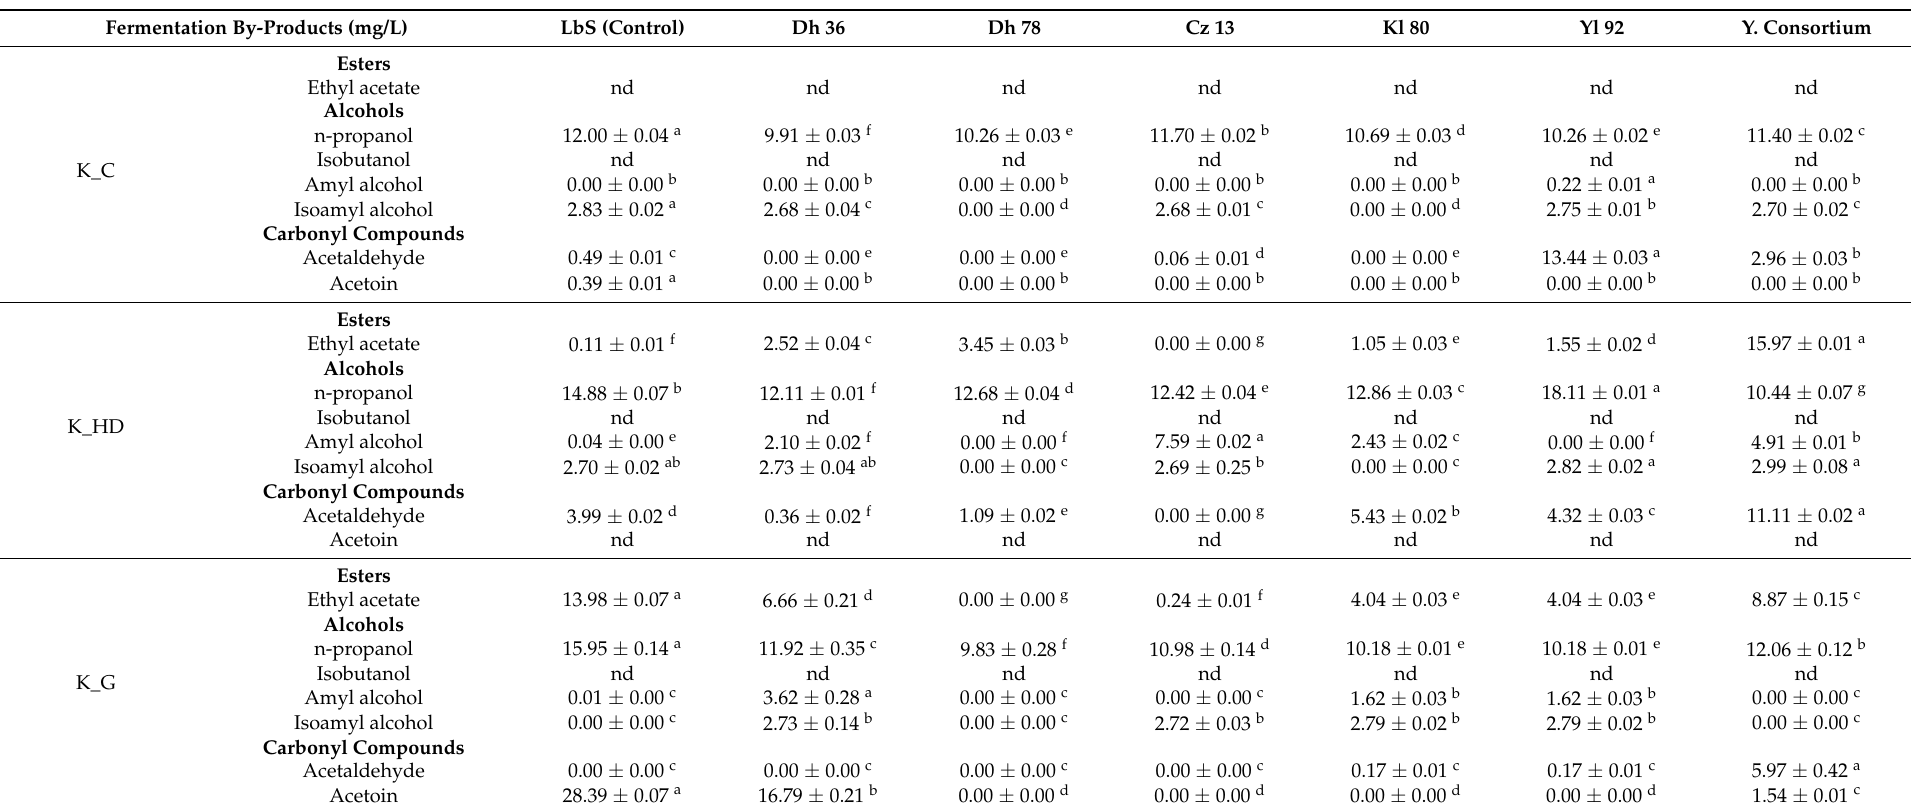
Table 3. Main fermentation by-products detected at the end of the storage at 4 ◦ C (5 weeks) in the kefir obtained by whole cow’s milk (K_C), lactose-free cow’s milk (K_HD), goat’s milk (K_G), and sheep’s milk (K_S). Data means ± standard deviations and values showing different superscript letters ( a,b,c,d,e,f,g ) within each line are significantly different according to Duncan tests ( p <